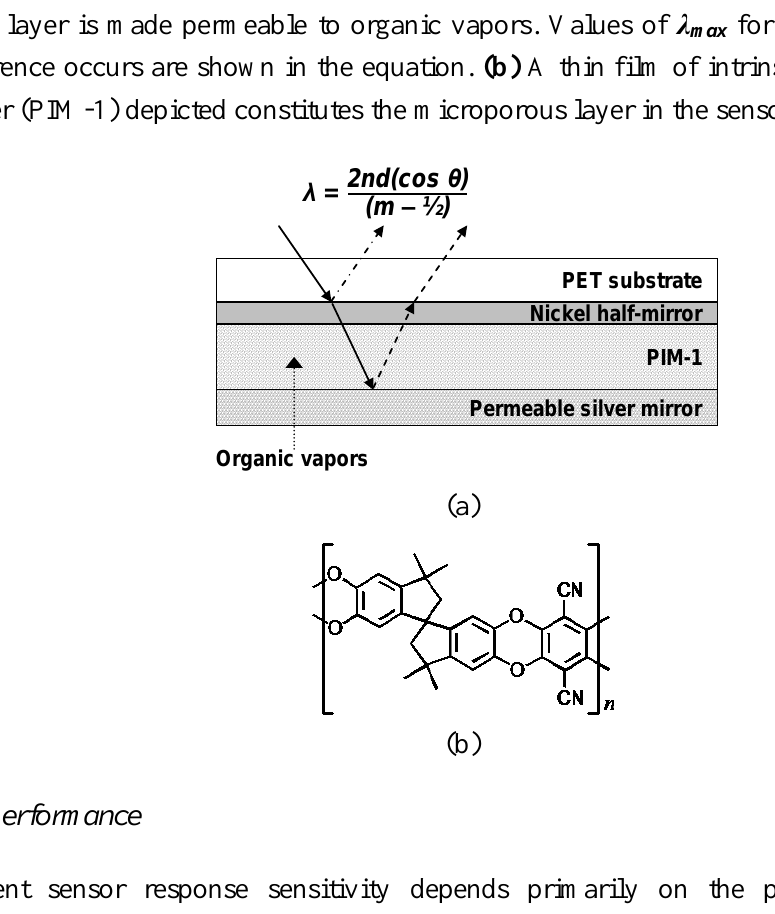
for which constructive max